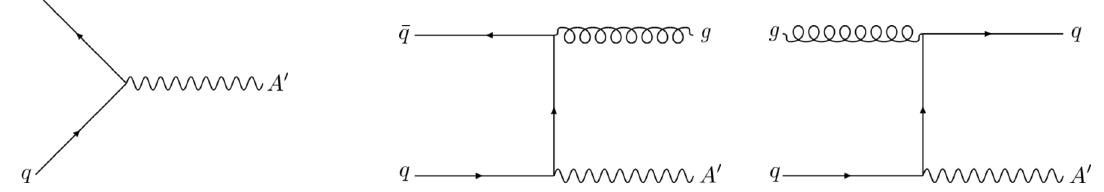
Figure 8. Main tree-level partonic QCD contributions: Drell-Yan-like production (left panel), associated production with the emission of extra QCD radiation (right